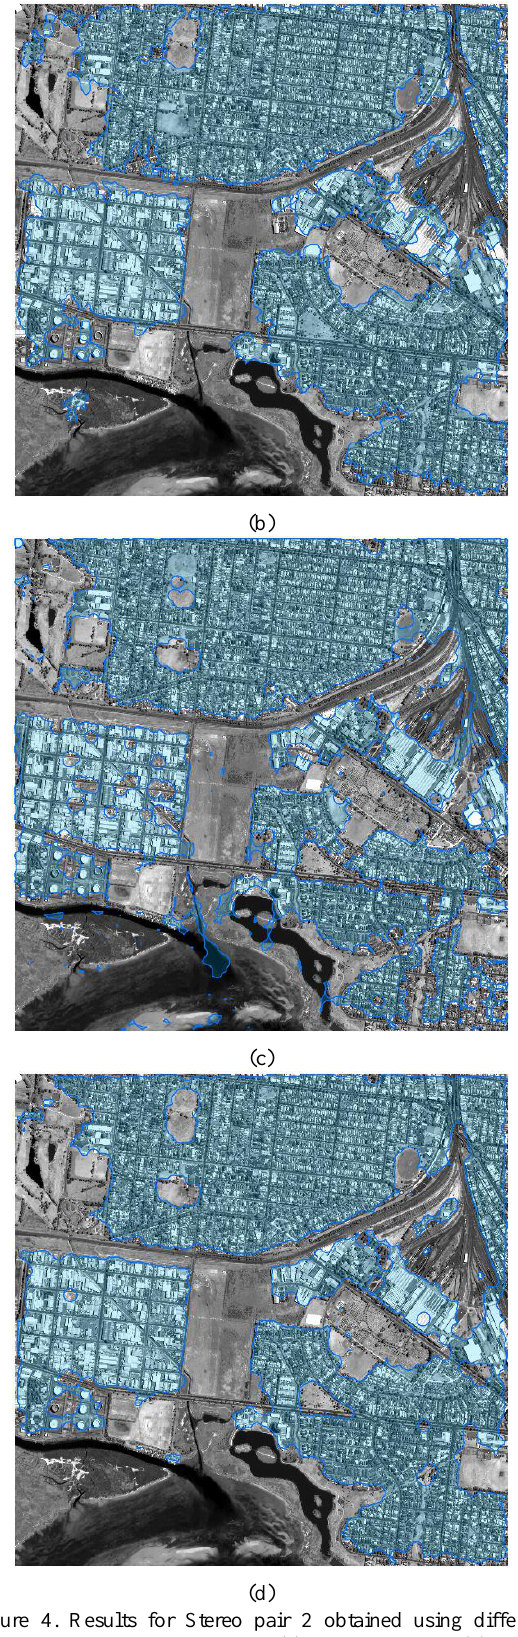
Figure 4. Results for Stereo pair 2 obtained using different built-up area detection methods. (a) Pantex method. (b) Gabor method. (c) nDSM method. (d) Our method.